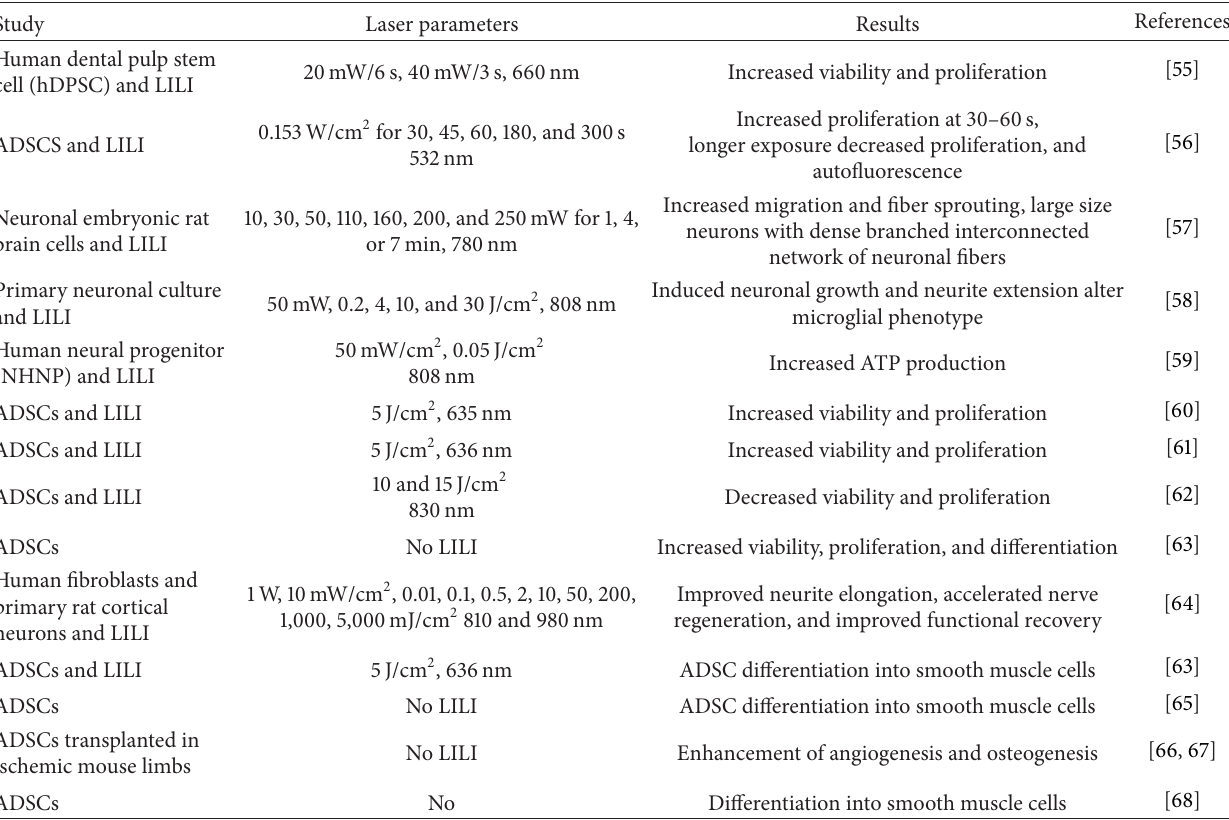
Table 2: Laser parameters used in stem cell